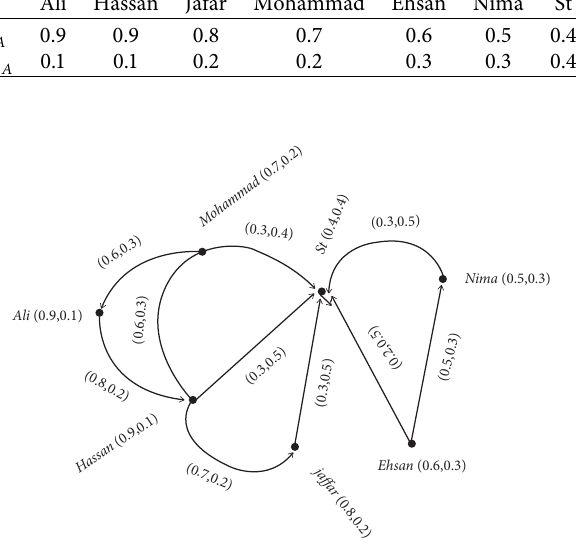
Figure 5: Vague influence